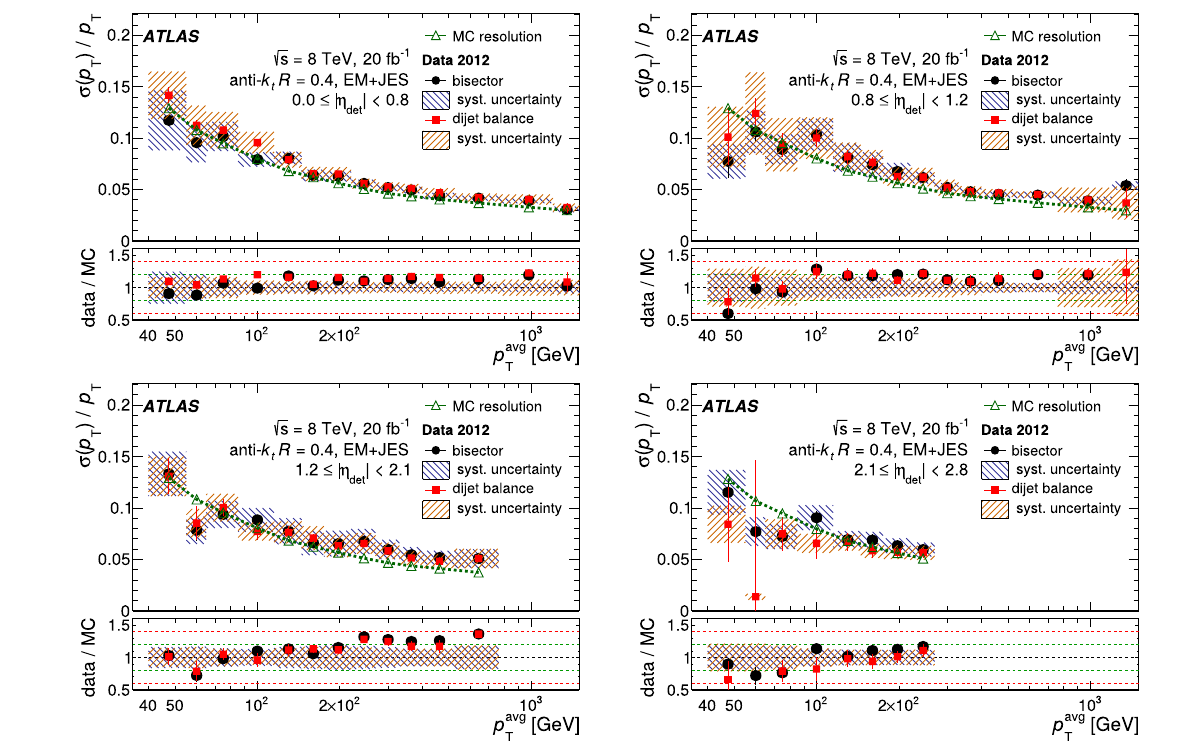
statistical uncertainty while the hashed band indicates the total system- atic uncertainty. Results are shown as a function of the jet p T in four regions of detector pseudorapidity: | η det | < 0 . 8, 0 . 8 ≤ | η det | < 1 . 2, 1 . 2 ≤ | η det | < 2 . 1, and 2 . 1 ≤ | η det | < 2 . 8. The lower panels show the data-to-MC ratio, and the thin dashed lines indicate 1 ± 0 . 2 and 1 ± 0 .